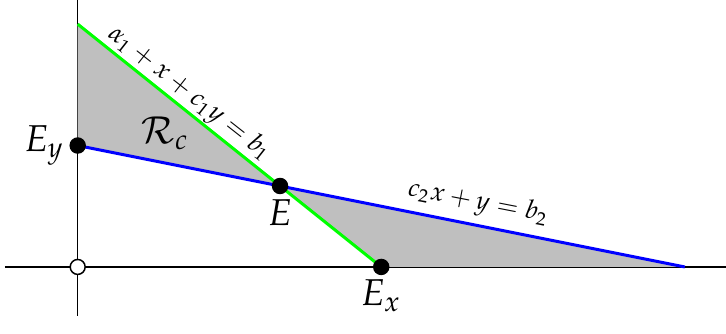
Figure 4. R b : = { ( x , y ) : x , y ≥ 0, c 2 x + y ≥ b 2 and α 1 + x + c 1 y ≤ b 1 } .